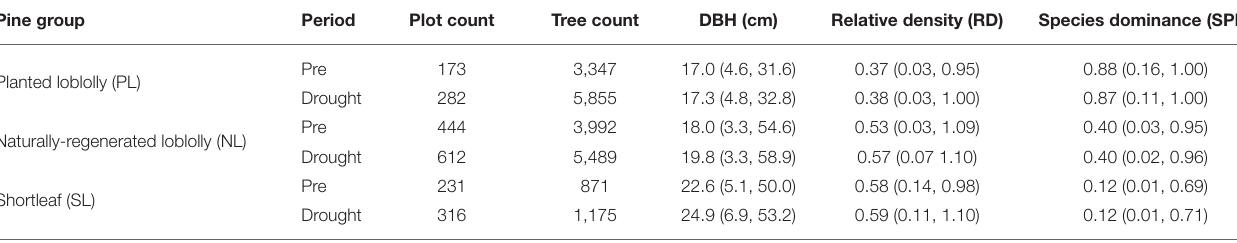
TABLE 1 | Summary information for the pine groups analyzed in the study. Pine group Period Plot